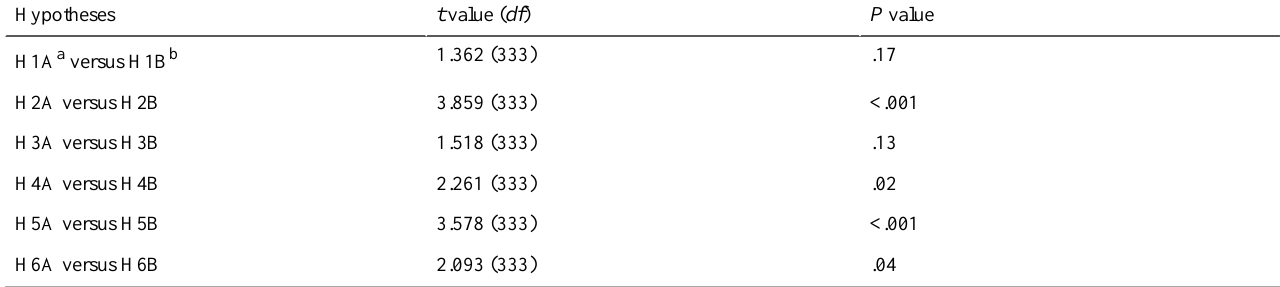
Table 3. Model comparison across